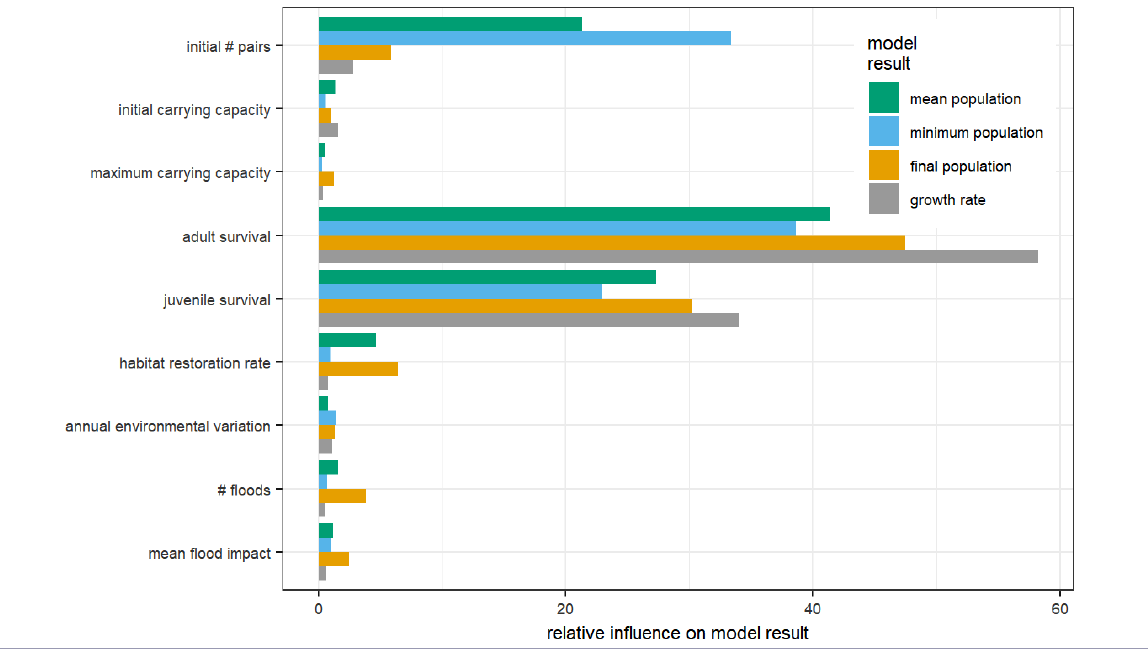
Fig. 7 . Summary of boosted regression tree analysis of parameter uncertainty on model results. Bar lengths show the relative influence of parameter on model result of interest. All analyses were conducted on a subset of 28,476 model replicates out of the total 720,000 replicates. Separate analyses were conducted for each model result that was